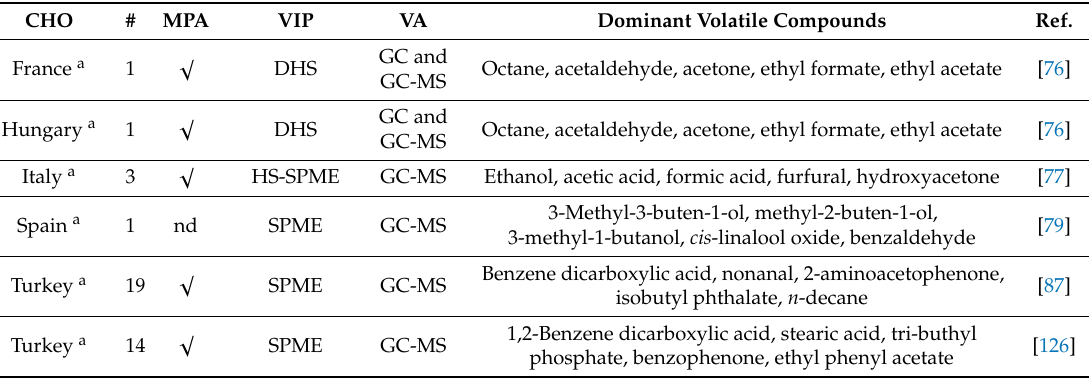
Table 17. Rhododendron honey’s main volatiles, with reference to the country of origin, number of samples, isolation and analysis procedures and five main volatile components. Unless otherwise specified, the honeybee type was A. mellifera